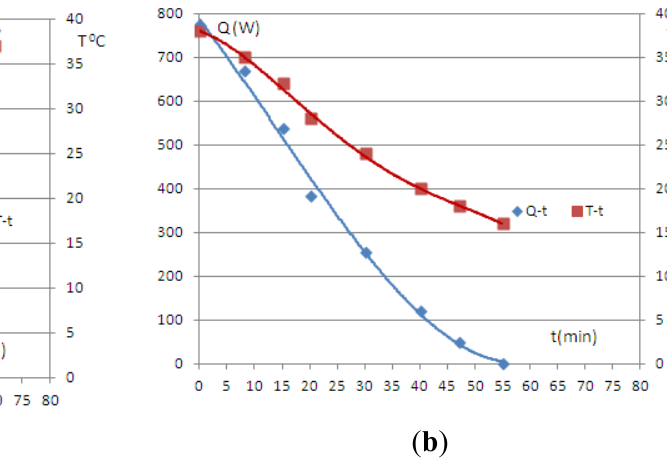
Figure 4. Heat fluxes and air outlet temperatures variation in times, in July: ( a ) heating process; ( b ) cooling